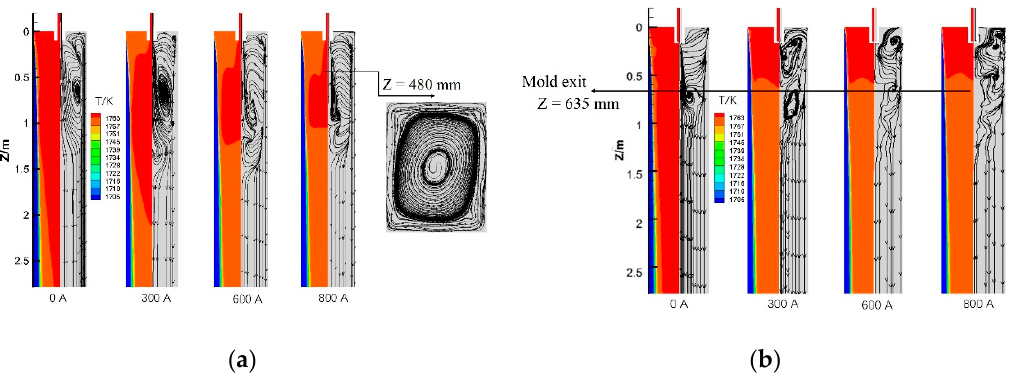
Figure 5. Temperature contour and flow streamline on wide symmetry plane: ( a ) single-port nozzle; ( b ) five-port nozzle.